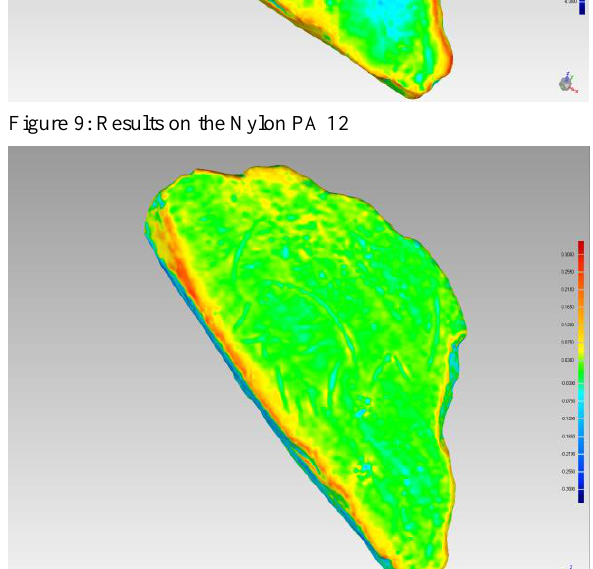
Figure 10 : Results on the